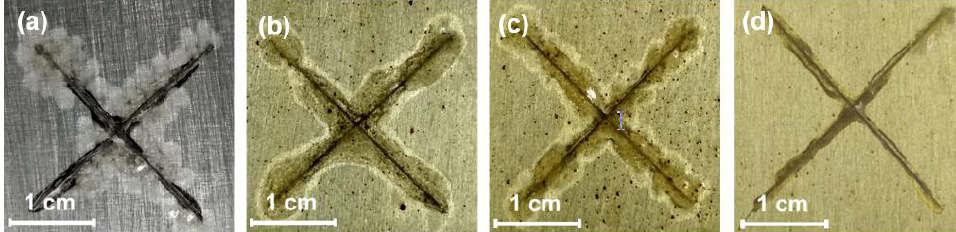
Figure 3. Photos of the coating samples containing different contents of CeTar after 48 h Machu test: ( a ) 0 wt% CeTar; ( b ) 1.5 wt% CeTar; ( c ) 3 wt% CeTar; ( d ) 5 wt% CeTar.